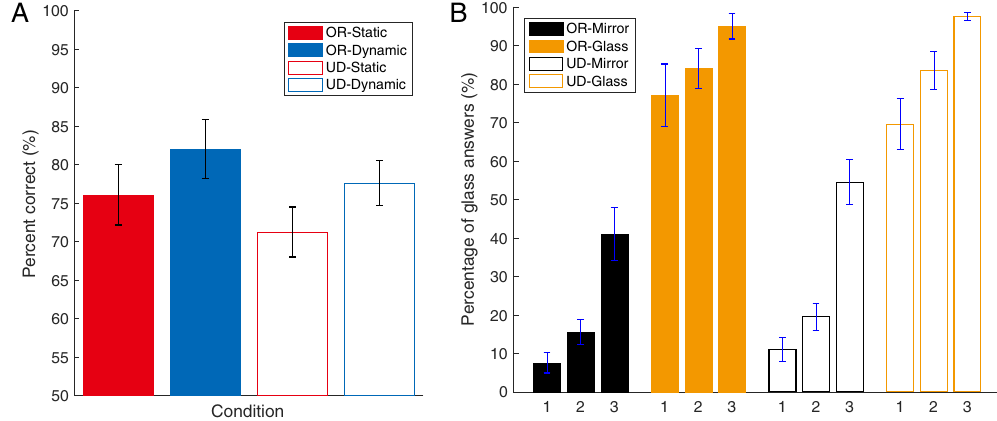
Figure 2. Perceptual material discrimination between mirror and glass. ( A ) Results for perceptual material discrimination under two presenting conditions, along with the rotating conditions. The horizontal axis indicates each condition combined with the rotating and presenting conditions. The vertical axis indicates the percentage of correct answers. ‘OR’ signifies original, and ‘UD’ signifies upside-down stimuli. Averages and standard errors among observers were obtained. The error bars represent the standard error of the mean across all ten observers. ( B ) Percentage of glass answers for different shapes. The horizontal axis indicates the shape number and the vertical axis indicates the percentage of glass answers. Different numbers along the horizontal axis indicate different shapes. The symbols are the same as in A .